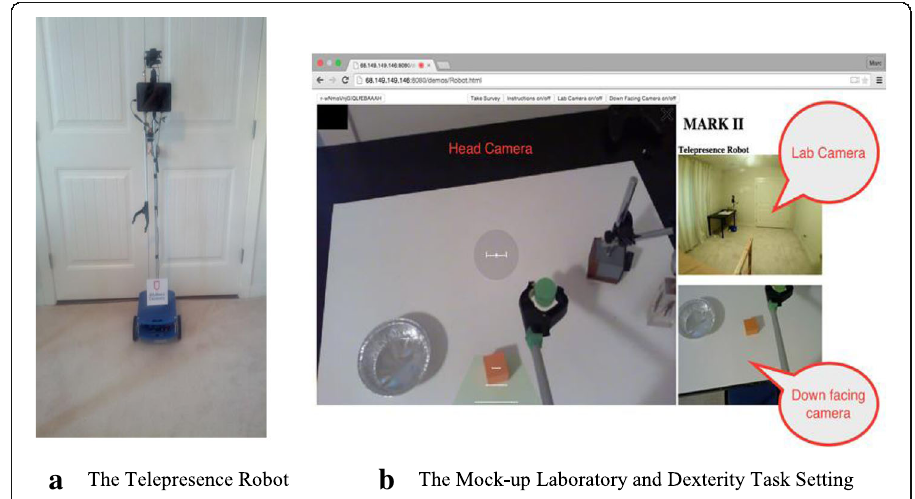
Fig. 6 The telepresence robot and the mock-up laboratory setting. a The telepresence robot. b The mock- up laboratory and dexterity task